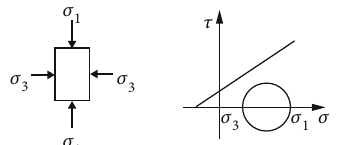
Figure 1: The stress state under